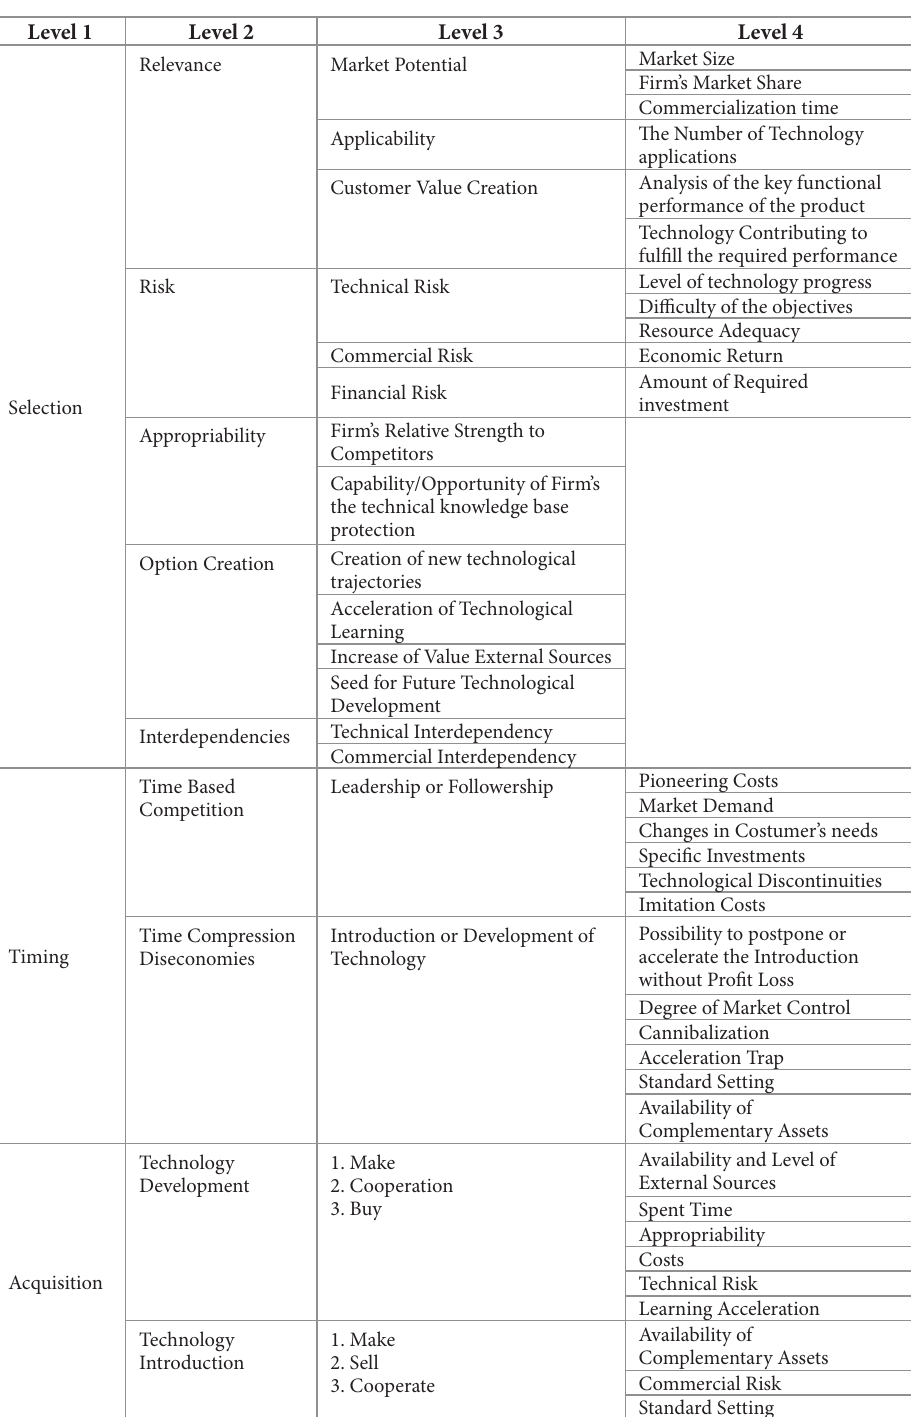
Table 2. Levels and factors of Chiesa’s model Level 1